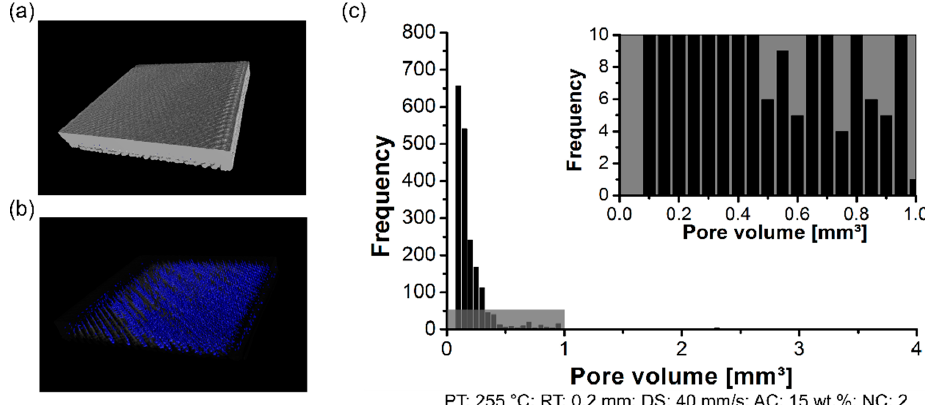
Figure 7. Pore distribution on the 3D ‐ printed ABS for condition one (PT: 255 °C, RT: 0.2 mm, DS: 40 mm/s, AC: 15 wt.%, and NC: 2): ( a ) scanned volume, ( b ) pores distribution, and ( c ) pore volume histogram.